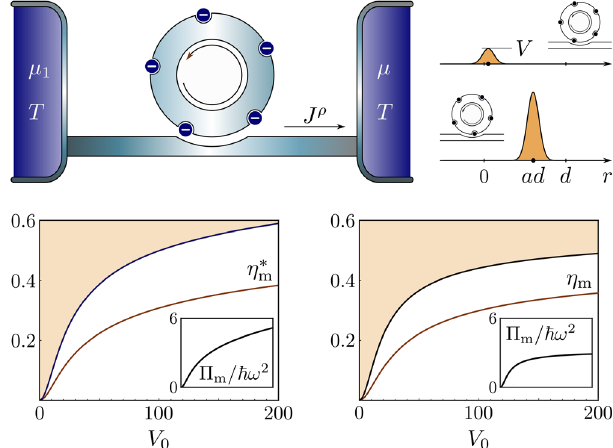
FIG. 4. Quantum paddle wheel motor. Top: setup. A narrow coherent conductor, which is placed between two isothermal reservoirs with chemical potentials μ 1 and μ < μ 1 , is in contact with a mesoscopic wheel, the rotor, which carries negative charges on its surface acting as electrostatic paddles. The electric current J ρ pushes the potential barrier that is created by a passing charge to the right, thus driving the rotation of the wheel. Bottom: the left-hand plot shows the maximum efficiency (69) of the motor as a function of the strength of the barrier V 0 with the shaded area corresponding to the bound (63). The inset shows the generated motive power over the same range of V 0 as in the main panel. For comparison, the efficiency and the motive power are plotted on the right-hand side for fixed bias v ¼ 10 . For all plots, we have set χ μ ¼ 4 π